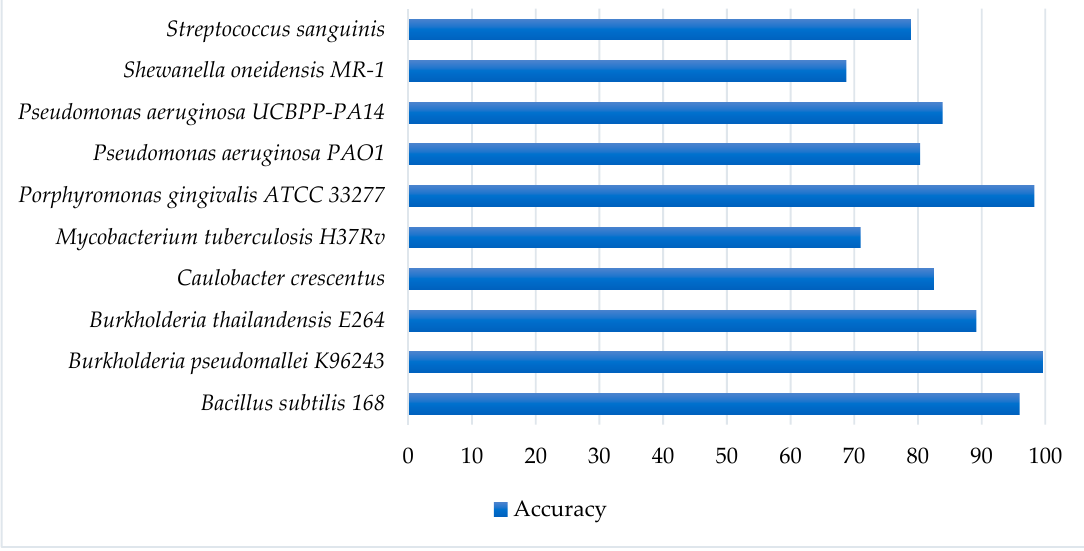
Figure 2. Performance results of identifying essential genes in representative cross-species datasets using the proposed model. Detailed information and predictive accuracy of all species are shown in Supplementary Table S2.